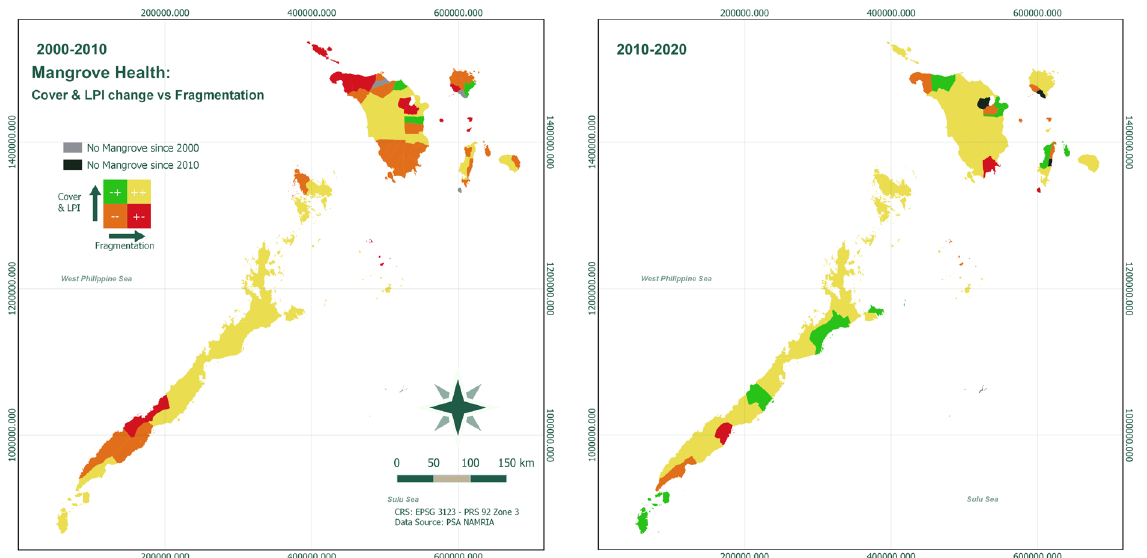
Figure 4 . Decadal Mangrove landscape health quadrant maps of cities/towns in terms of area vs fragmentation metrics. To further inspect if fragmentation occurs for each